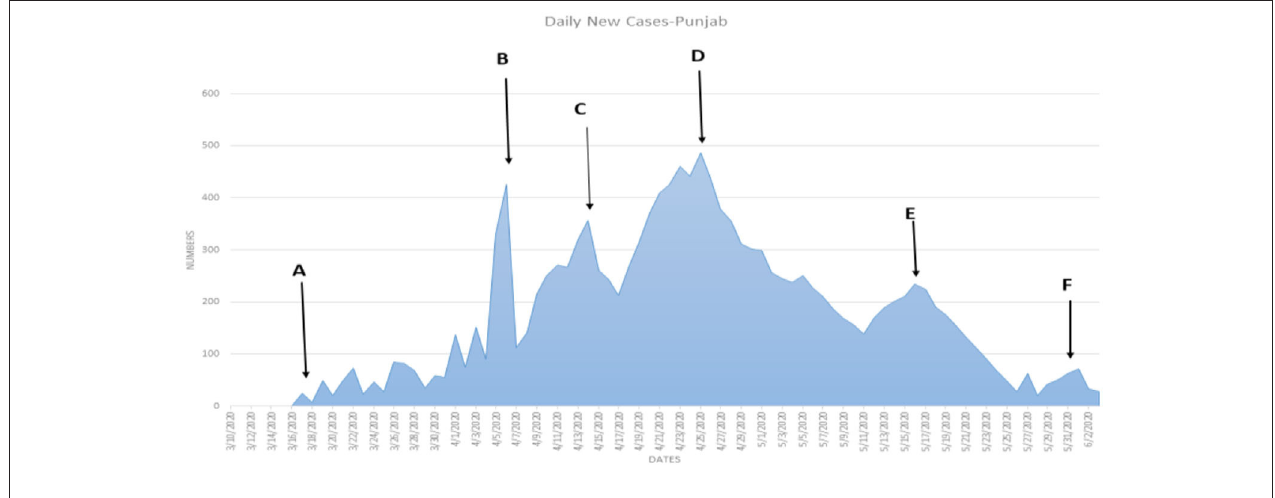
FIGURE 2 | (A–F) The number of cases in Punjab.